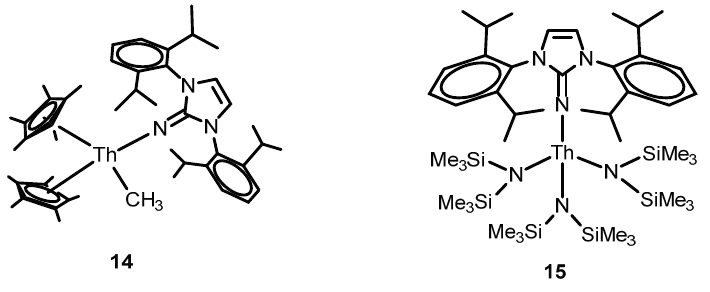
Figure 6. Imidazolin-2-iminato thorium complexes 14 and 15 applied as pre-catalysts for the Tishchenko reaction [74,75].